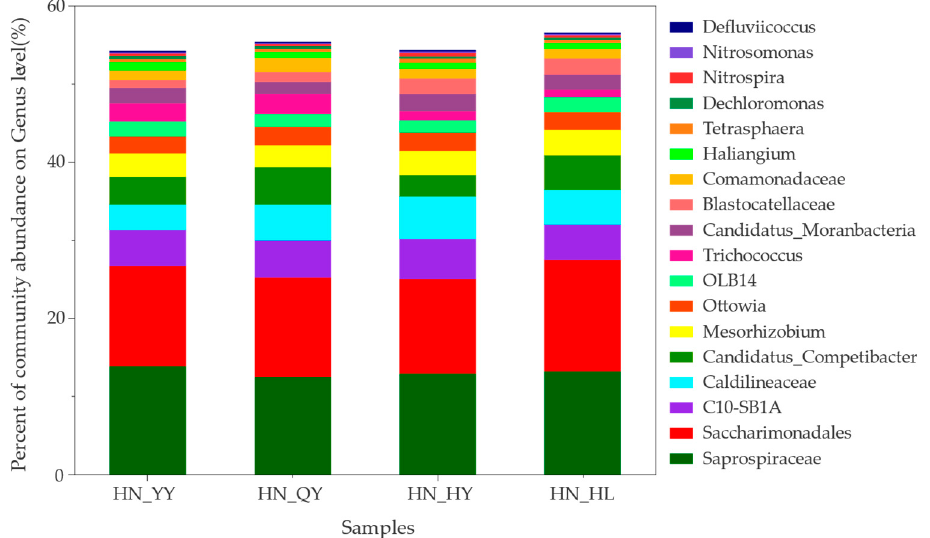
Figure 3. Relative abundance of the predominant organic matter, nitrogen, and phosphorus removal organnisms (genus level) in the anaerobic sludge (HN_YY), anoxic sludge (HN_QY), aerobic sludge (HN_HY), and return sludge (HN_HL).